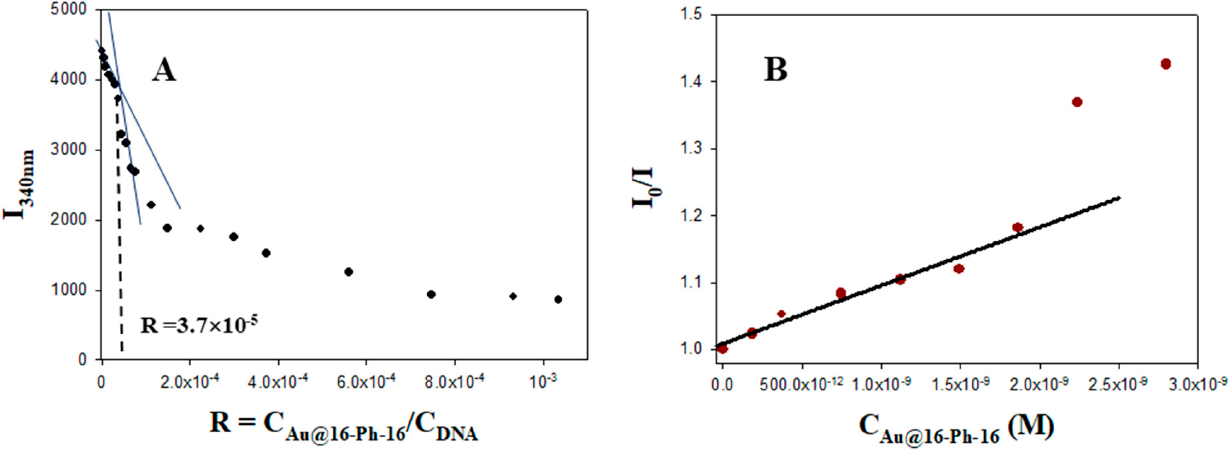
Figure 1. Fluorescence experiments with the DNA/5-Fu (5-fluorouracil) system in the presence of different C Au@16-Ph-16 at 298.0 K in a cacodylate buffer (ionic strength (I) = 1.63 mM and PH = 7.4); C 5-Fu = 41.7 µ M and C DNA = 50.0 µ M. ( A ) Plot of I 340 nm versus the molar ratio, R = C Au@16-Ph-16 /C DNA ( B ) Stern–Volmer plot of DNA/5-Fu system at different C